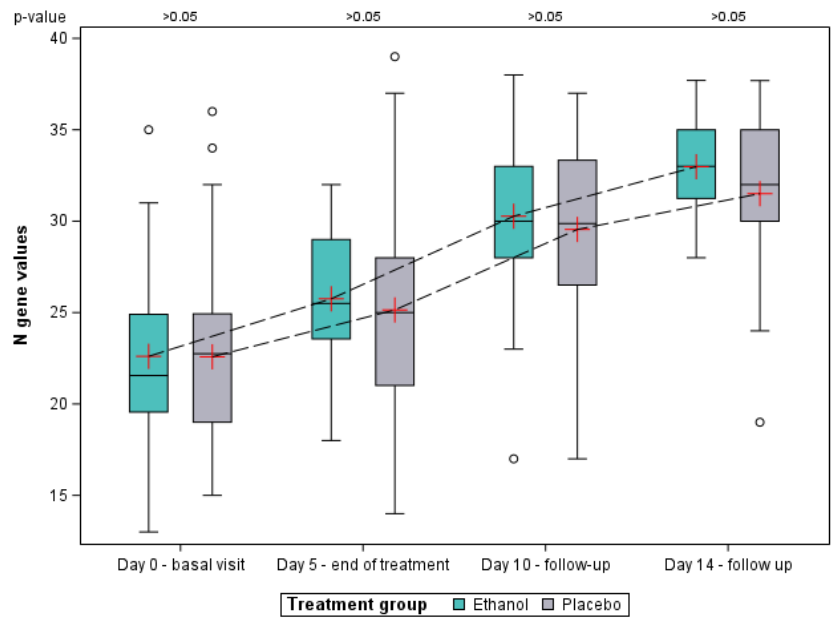
Figure 5. Cycle threshold (Ct) values oh the N gene up to visit on day 14. Mean is represented by a red cross, median is represented by the horizontal line contained in the box, and the first and third quartiles by the lower and upper limits of the box, respectively. The mean Ct values at each visit are linked together by a dashed line for each of the groups.